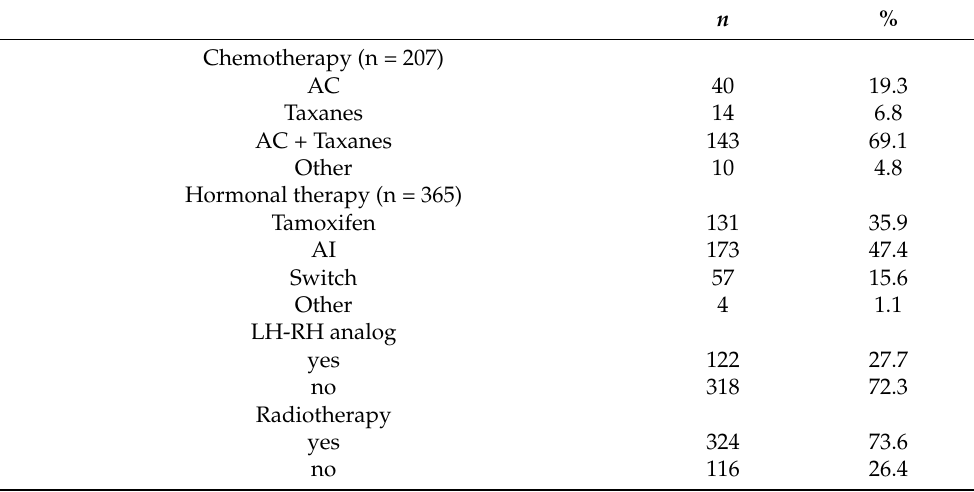
Table 2. BC patients’